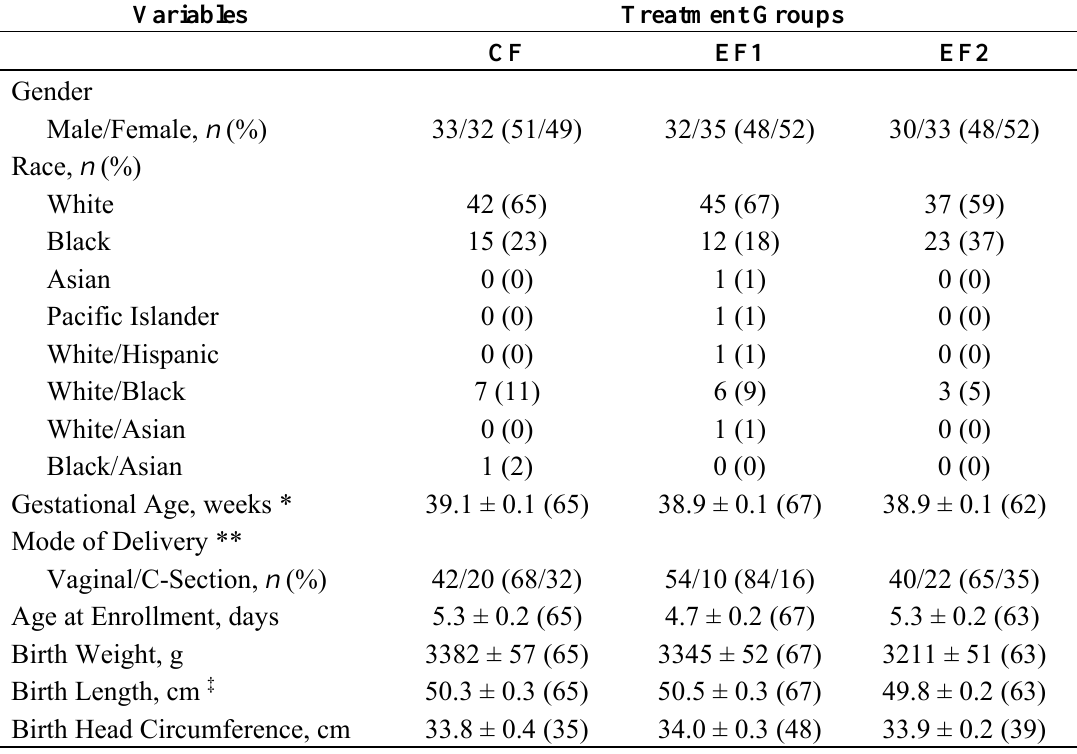
Table 2. Demographic and entrance data for randomized study subjects.